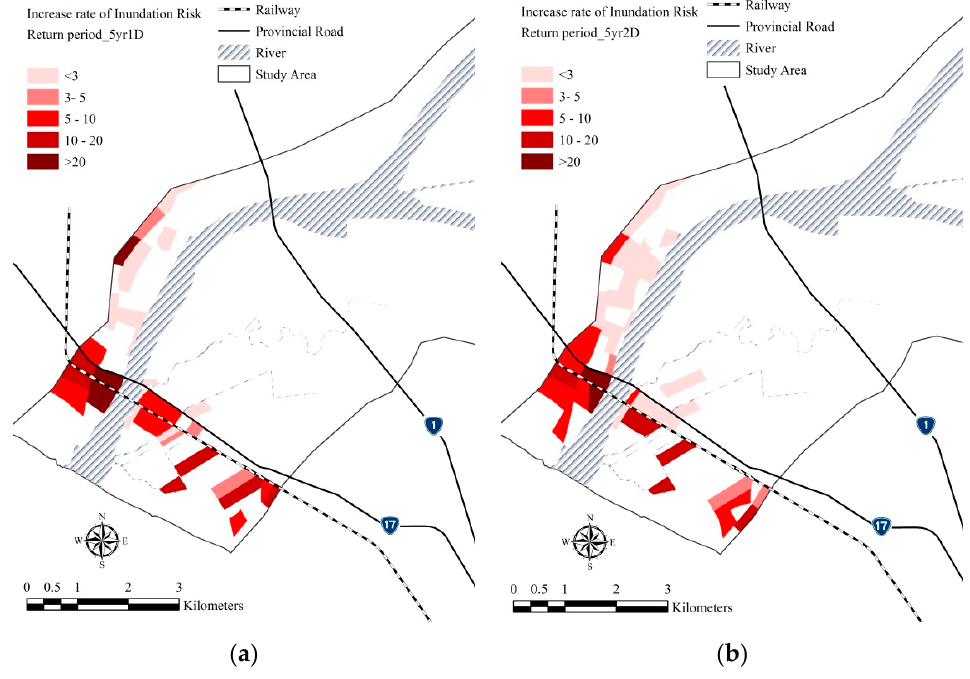
Figure 13. ( a ) Distribution map of inundation risk increase after land subsidence for a one-day storm under a 5-year return period; ( b ) Distribution map of inundation risk increase after land subsidence for a two-day storm under a 5-year return period.